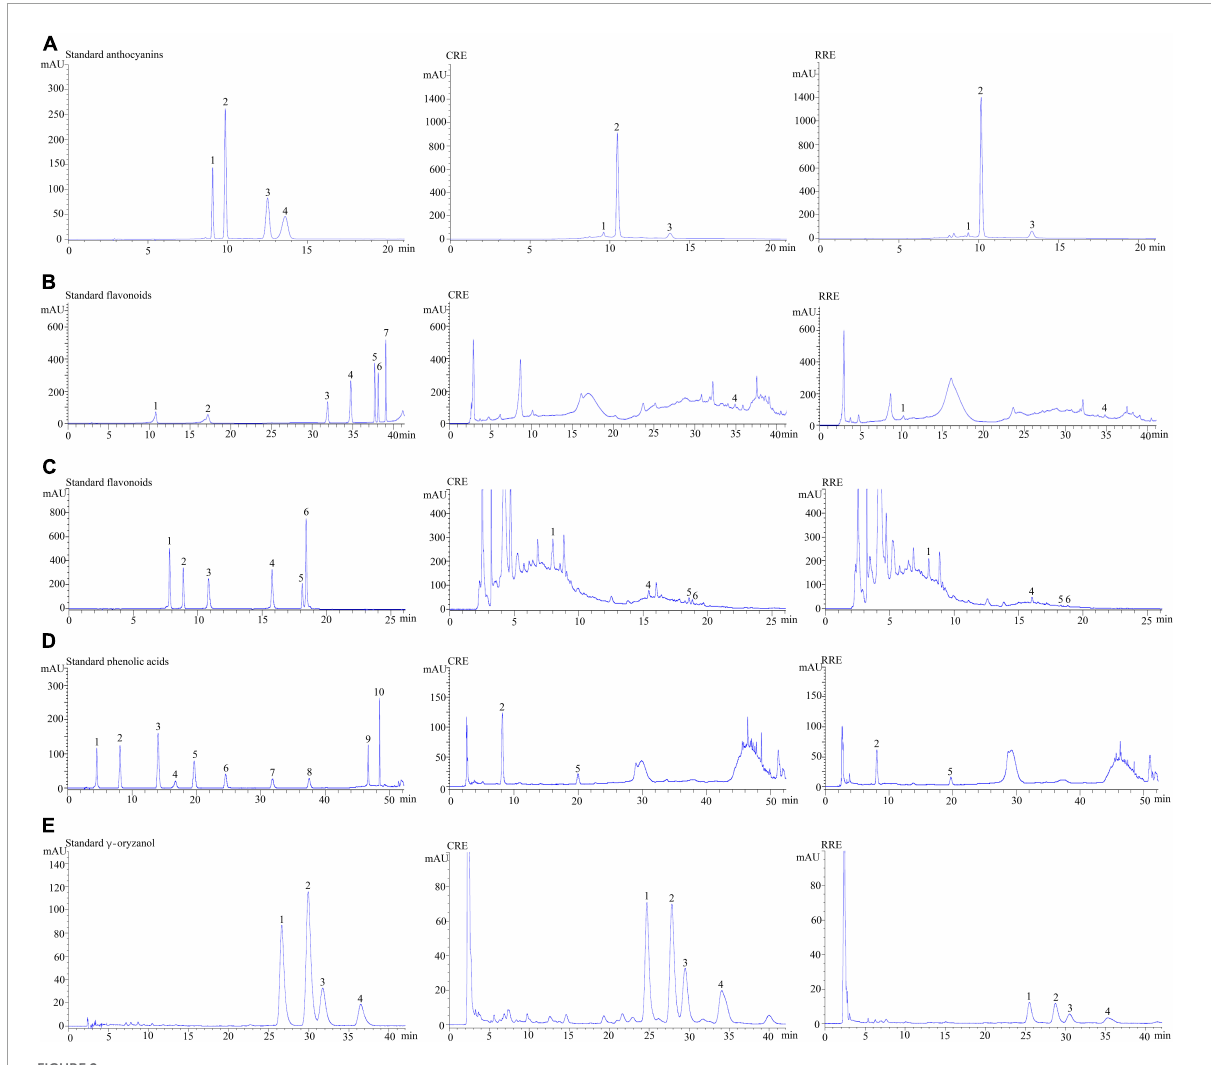
FIGURE2 Chromatograms of some of the phytochemicals in glutinous purple rice. (A) Anthocyanins; peaks 1–4 represent delphinidin-3-glucoside, cyanidin-3-glucoside, peonidin-3-glucoside, and malvidin-3-glucoside, respectively. (B) Flavonoids; peaks 1–6 represent catechin, epicatechin, rutin, isorhamnetin-3-glucoside, luteolin, and apigenin, respectively. (C) Flavonoids; peaks 1–6 represent quercetin-3-glucoside, quercetrin, myricetin, quercetin, tricin, and kaempferol, respectively. (D) Phenolic acid; peaks 1–10 represent gallic acid, protocatechuic acid, 4-hydroxybenzoic acid, chlorogenic acid, syringic acid, p-coumaric acid, ferulic acid, ellagic acid, trans-cinnamic acid, and vanillic acid, respectively. (E) γ -Oryzanol; peaks 1–4 represent β -sitosteryl ferulate, campesteryl ferulate, cycloartenyl ferulate, and 24-methylene cycloartanyl ferulate, respectively. CRE, cooked glutinous purple rice extract; RRE, raw glutinous purple rice